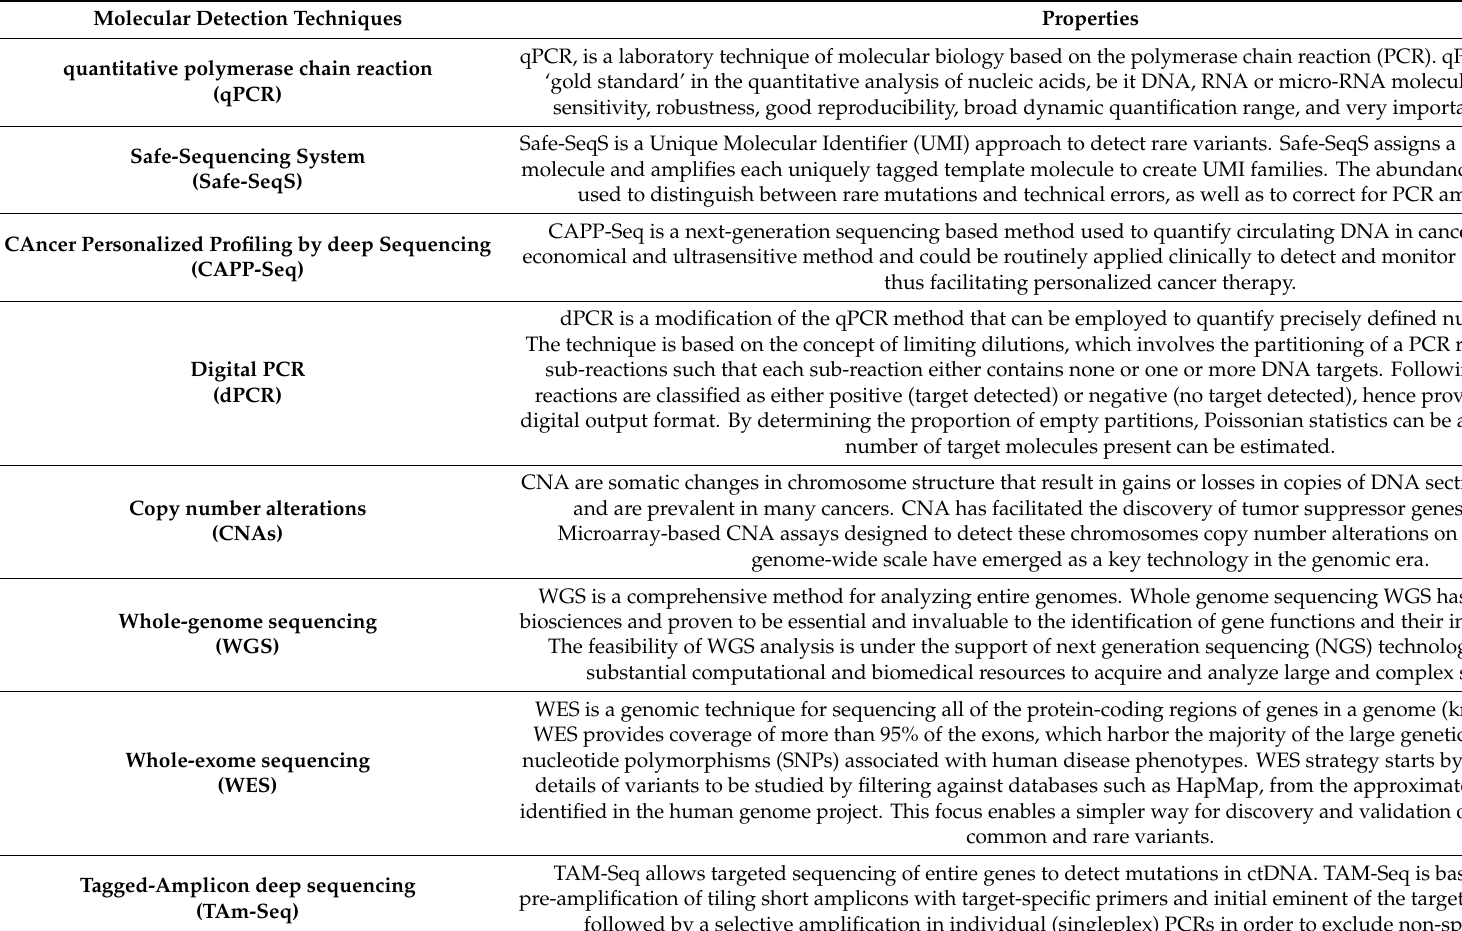
Table 1. Properties of the di ff erent molecular detection